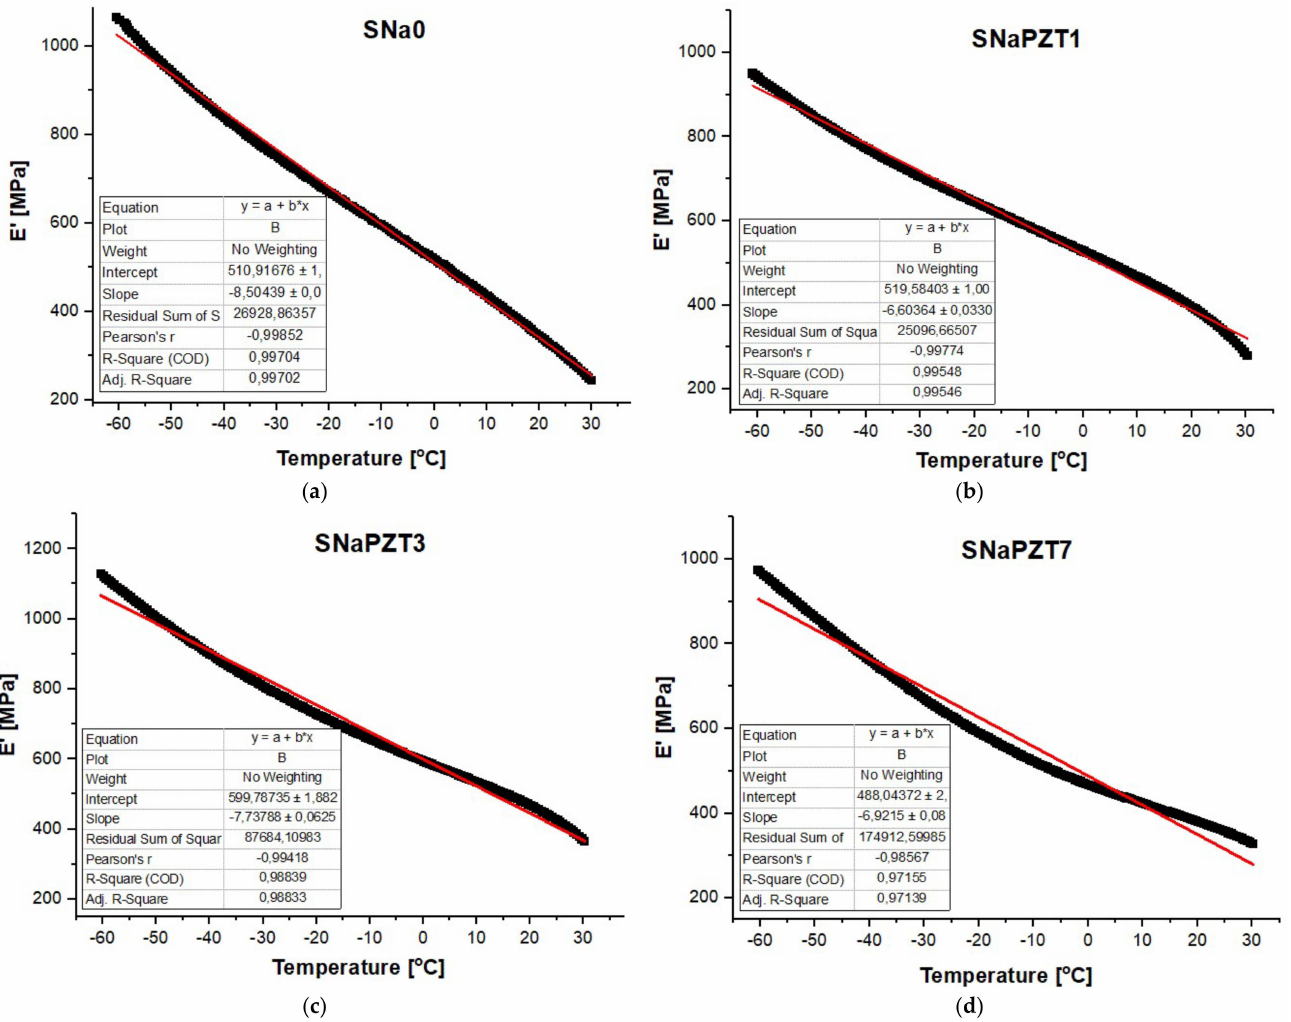
Figure 13. Linear behavior of storage modulus (E (cid:48) ) in terms of temperature: ( a ) SNa0, ( b ) SNaPZT1, ( c ) SNaPZT3 and ( d )